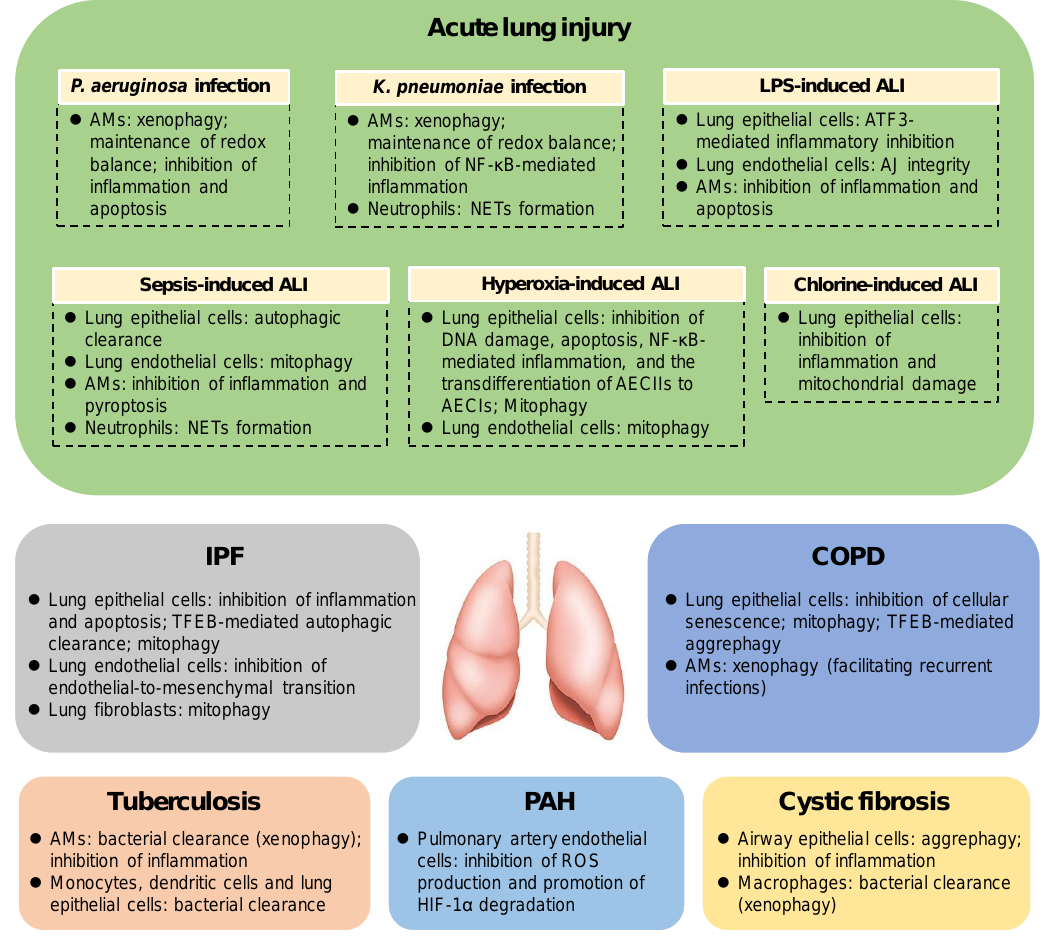
response, redox balance, DNA damage repair, apoptosis, pyroptosis, cellular senescence,